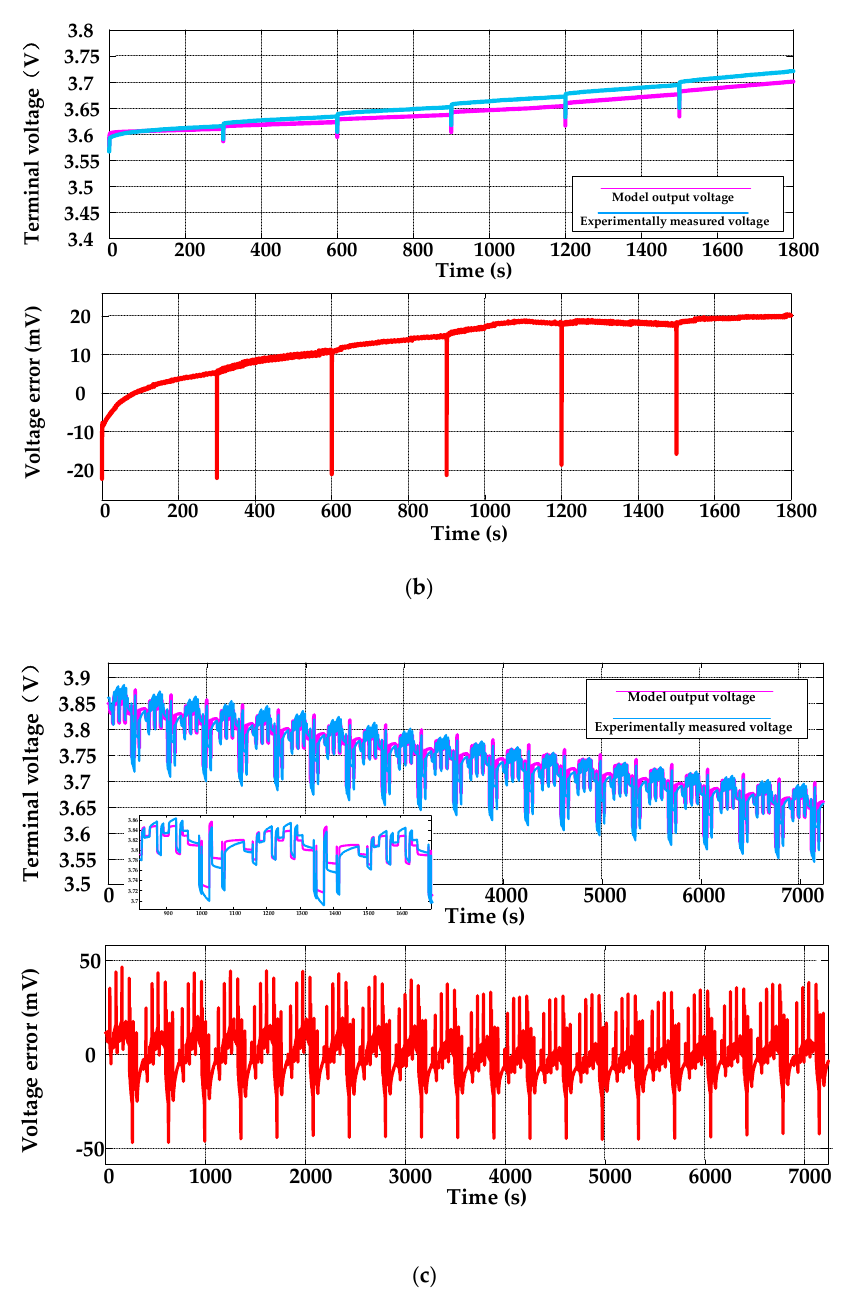
Figure 9. Model verification results at 25 °C: ( a ) model output voltage and its error for the discharging test, ( b ) model output voltage and its error for the charging test, and ( c ) model output voltage and its error for the dynamic stress test (DST). The magnified mini-plot is an enlarged view for the time range of 800 s–1800 s.